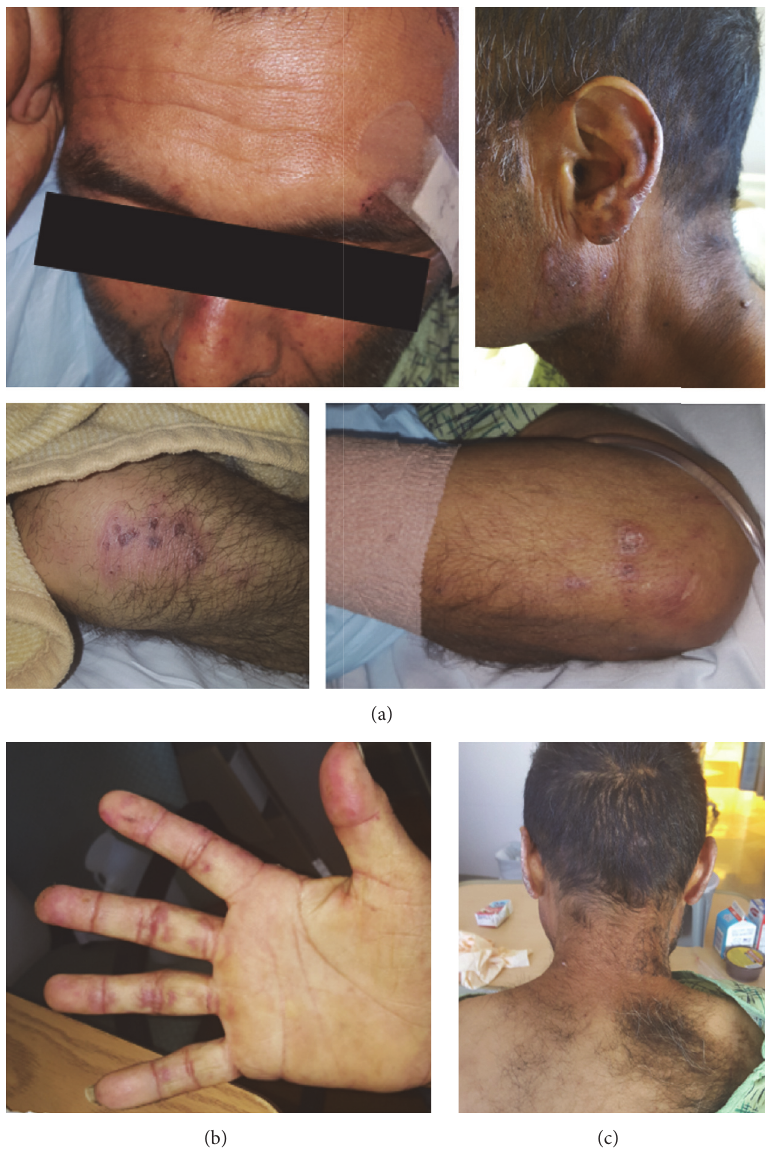
Figure 1: Physical findings of (a) violaceous patchy, discoid-like lesions above eyebrows, on side of face, ears, extensor surface of elbows, and knees, and malar-like rash on bridge of nose, (b) subcutaneous purpuric rash on palmar surface of fingers, and (c) alopecia of the head and hirsutism of the